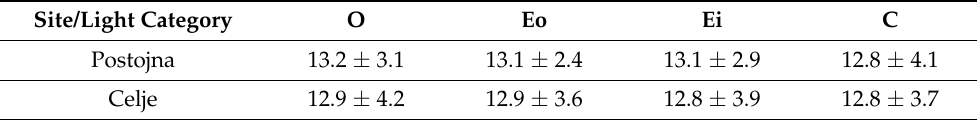
Table 2. Foliar nitrogen (Ntot; mg/g) for all light categories (O-open; Eo- outer forest edge; Ei-inner forest edge and C-complete canopy cover) and both sites (N = 8). Mean values with standard error of the mean are given.